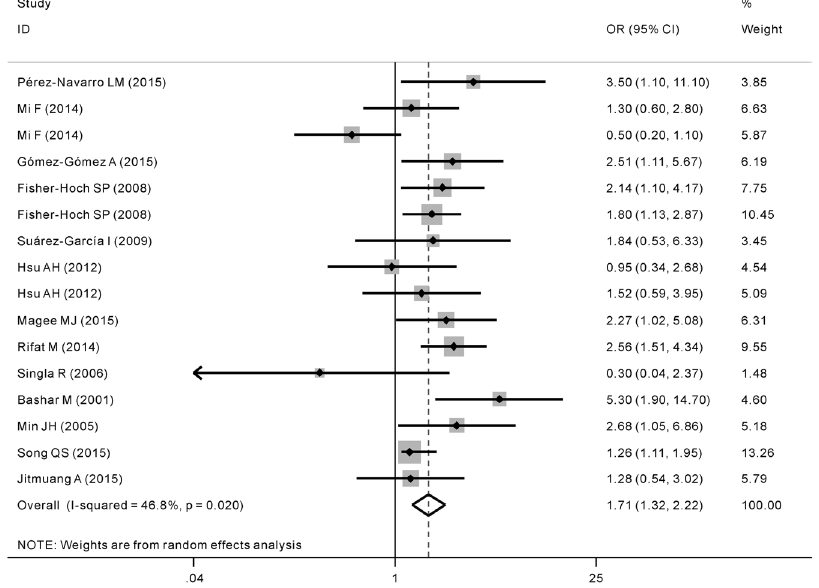
Figure 2. Forest plot of odds ratio (OR) assessing the association between diabetes mellitus and multidrug resistance tuberculosis. CI, confidence interval.